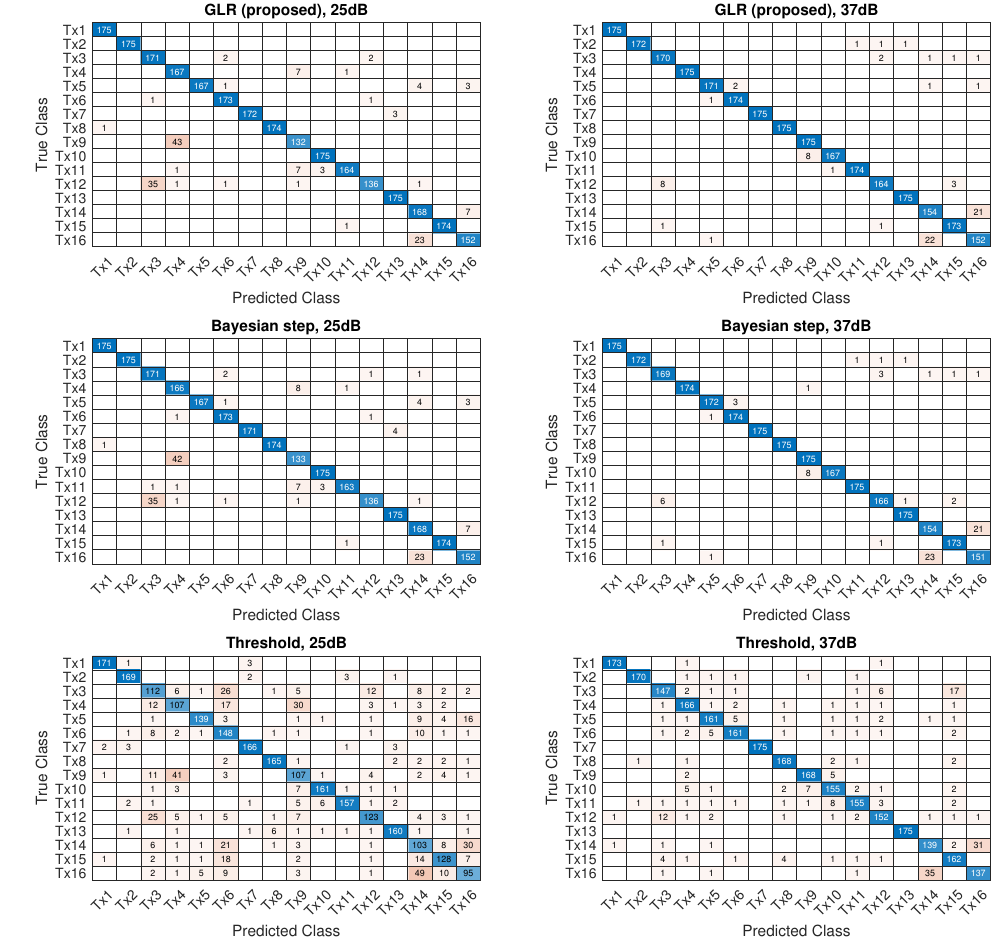
Figure 14. Confusion matrices for device classification using the RF fingerprints detected by three different detection methods at 25 dB ( left panel ) and 37 dB ( right panel )